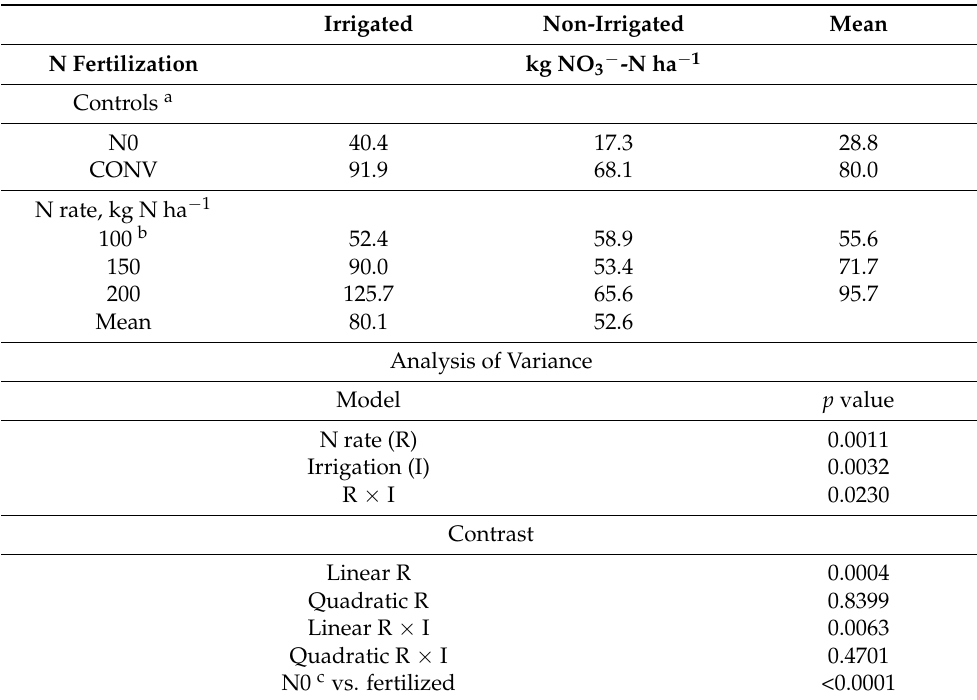
Table 3. Irrigation and nitrogen rate effect on seasonal NO 3 − -N leaching.